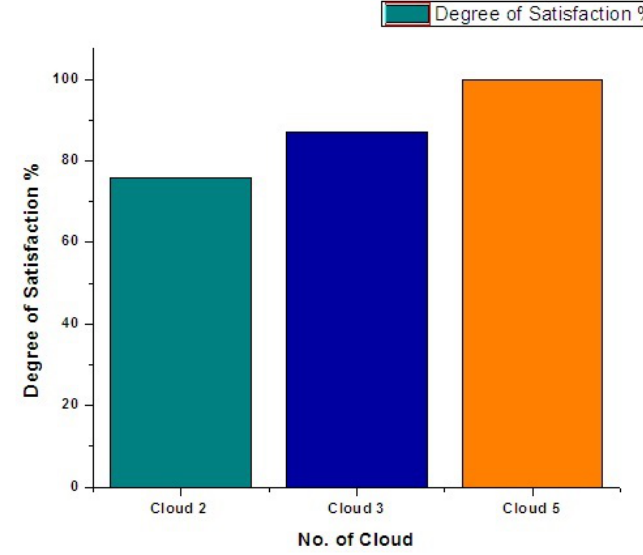
Figure 14. Degree of user satisfaction